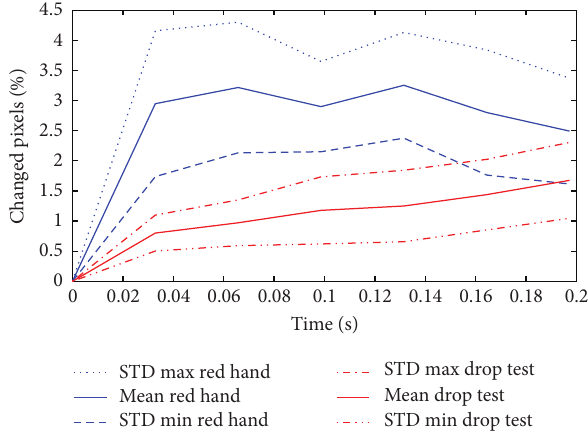
Figure 6: Percentage of changed pixels of stimuli.